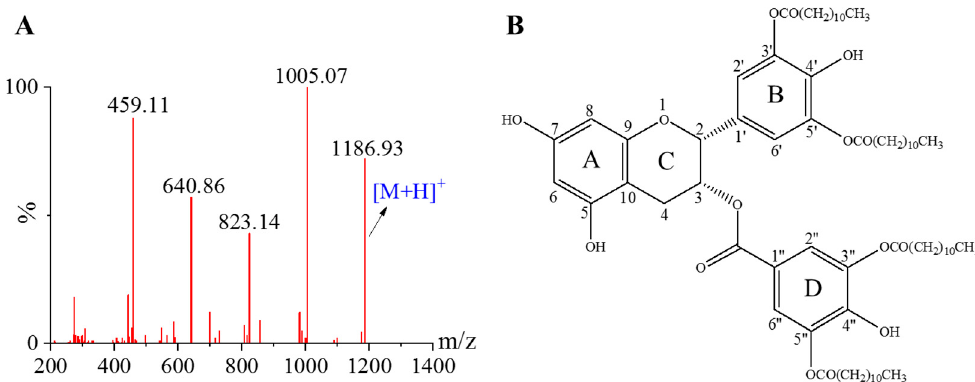
Figure 1. The ( A ) tandem mass spectrometry and ( B ) structure of lipophilized epigallocatechin gallate derivative (LEGCG).